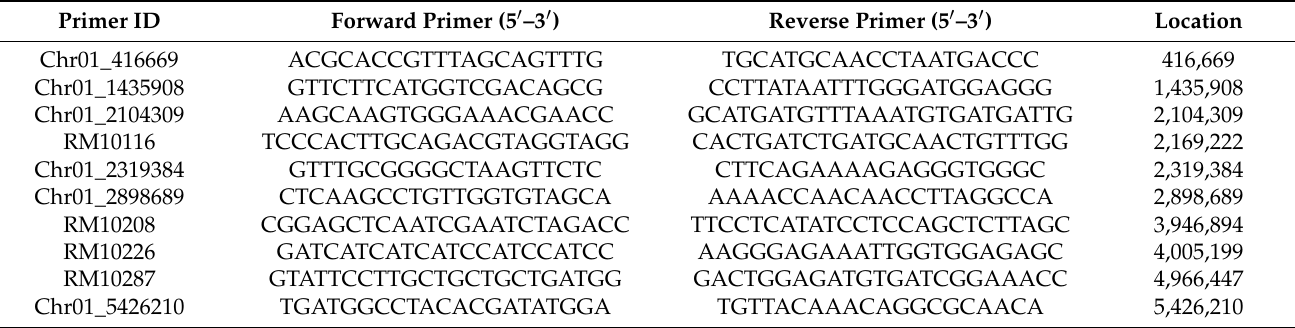
Figure A1. Linkage map constructed with 180 F 2:9 recombinant inbred lines (RILs) derived from a cross between Zenith and Ilpum. Table A1. InDel and SSR markers used for the fine mapping of qBK z .